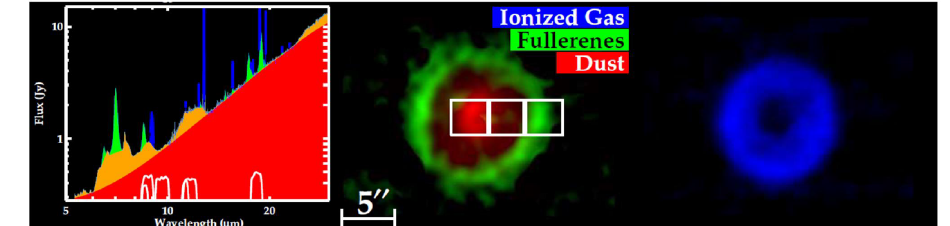
Figure 8. ( left ) Spitzer spectrum of Tc1; 6 images using Gemini/T-ReCS filter bandpasses (white curves) were processed with a filtered imaging decomposition tool, to create the false-color images showing the spatial distribution of fullerenes and dust ( center ), and ionized gas ( right ), color-coded to match the colors in the spectrum. Orange spectral features include mid-IR plateaus and PAHs. White rectangles show the size of the MRS mosaic footprint (J. Cami, priv. comm.